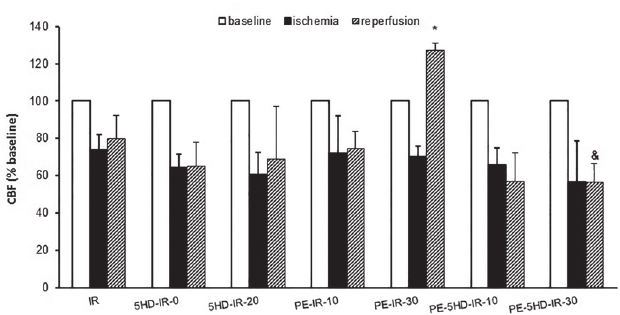
FIGURE 7 - The coronary blood flow (CBF) was recorded, at baseline, after 35 min of regional ischemia (ischemic myocardium), and after 60 minutes of reperfusion (reperfused myocardium), by using laser Doppler flowmeter LDF in ischemia/reperfusion (IR), 5HD perfused at onset of regional ischemia (5HD-IR-0), 5HD perfused 20 min of regional ischemia (5HD-IR-20), phenylephrine-early perconditioning 10 min of ischemia (PE-IR-10), phenylephrine-late perconditioning 30 min of ischemia (PE-IR-30), 5HD-phenylephrine Early perconditioning (5HD-PE-IR-10), 5HD-phenylephrine-late perconditioning (5HD-PE-IR-30). Repeated measure ANOVA was performed to compare between and within groups. * P<0.05 vs. IR group & P<0.05 vs. PE-IR-30 group . Data were expressed as a mean percentage of the baseline preischemia